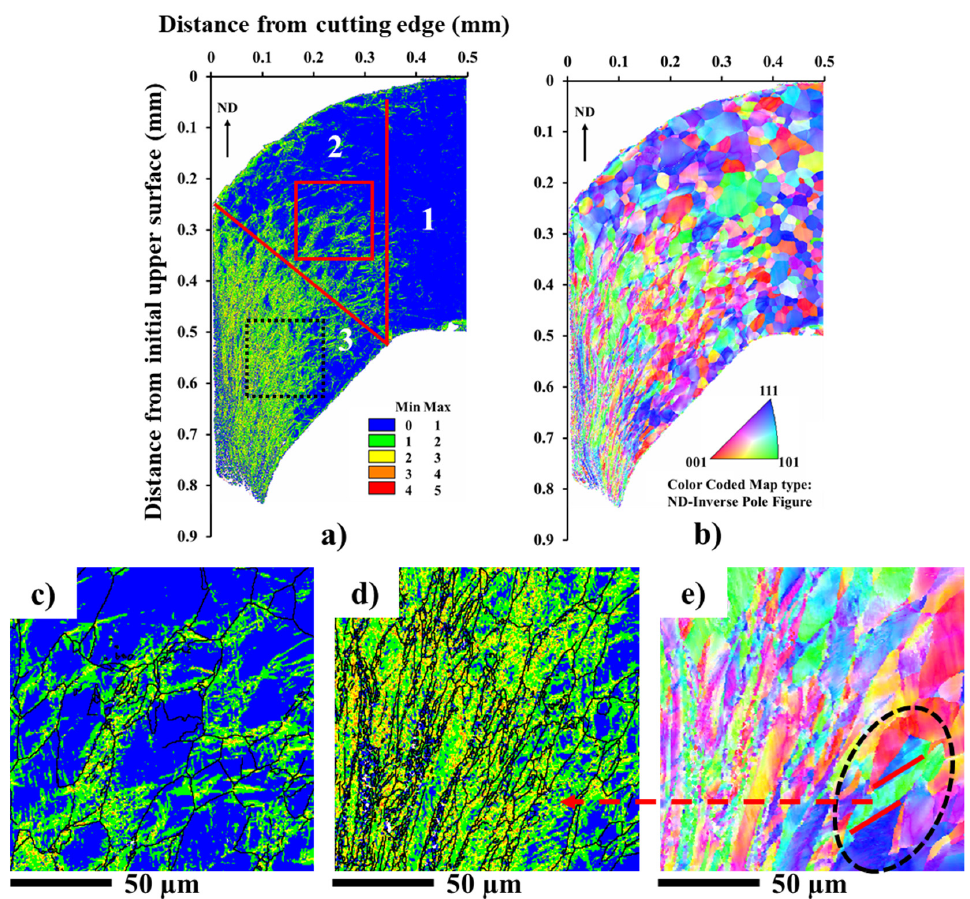
Figure 8. ( a ) KAM distribution map and ( b ) inverse pole figure (IPF) map obtained from EBSD analysis at the cutting edge of a punched sample; ( c ) KAM distribution map of red frame shown in area 2 of ( a ); ( d ) KAM distribution map; and ( e ) IPF map of black dotted frame shown in area 3 of ( a ). Black lines shown in ( a , c , d ) are the grain boundaries with misorientation greater than 15°.The black dotted circular frame and red lines in ( e ) show the presence of a shear band formed during punching.